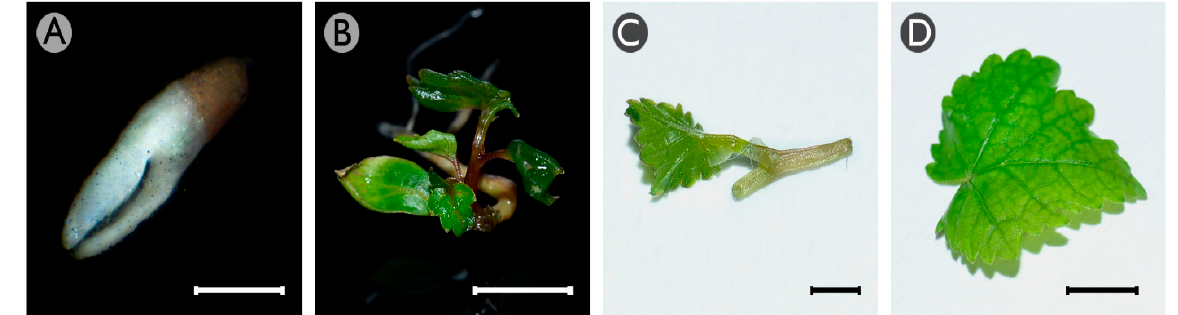
Figure 7. Grapevine ( Vitis vinifera L., cv. Mencía) explants used in this work. ( A ) Somatic embryo in the cotyledonary morphological stage, ( B ) recently germinated somatic embryo, ( C ) shoot apex, and ( D ) leaf from a grapevine plant maintained in vitro. Bars: 1 mm ( A , C ); 1 cm ( B ); 0.5 cm ( D ).